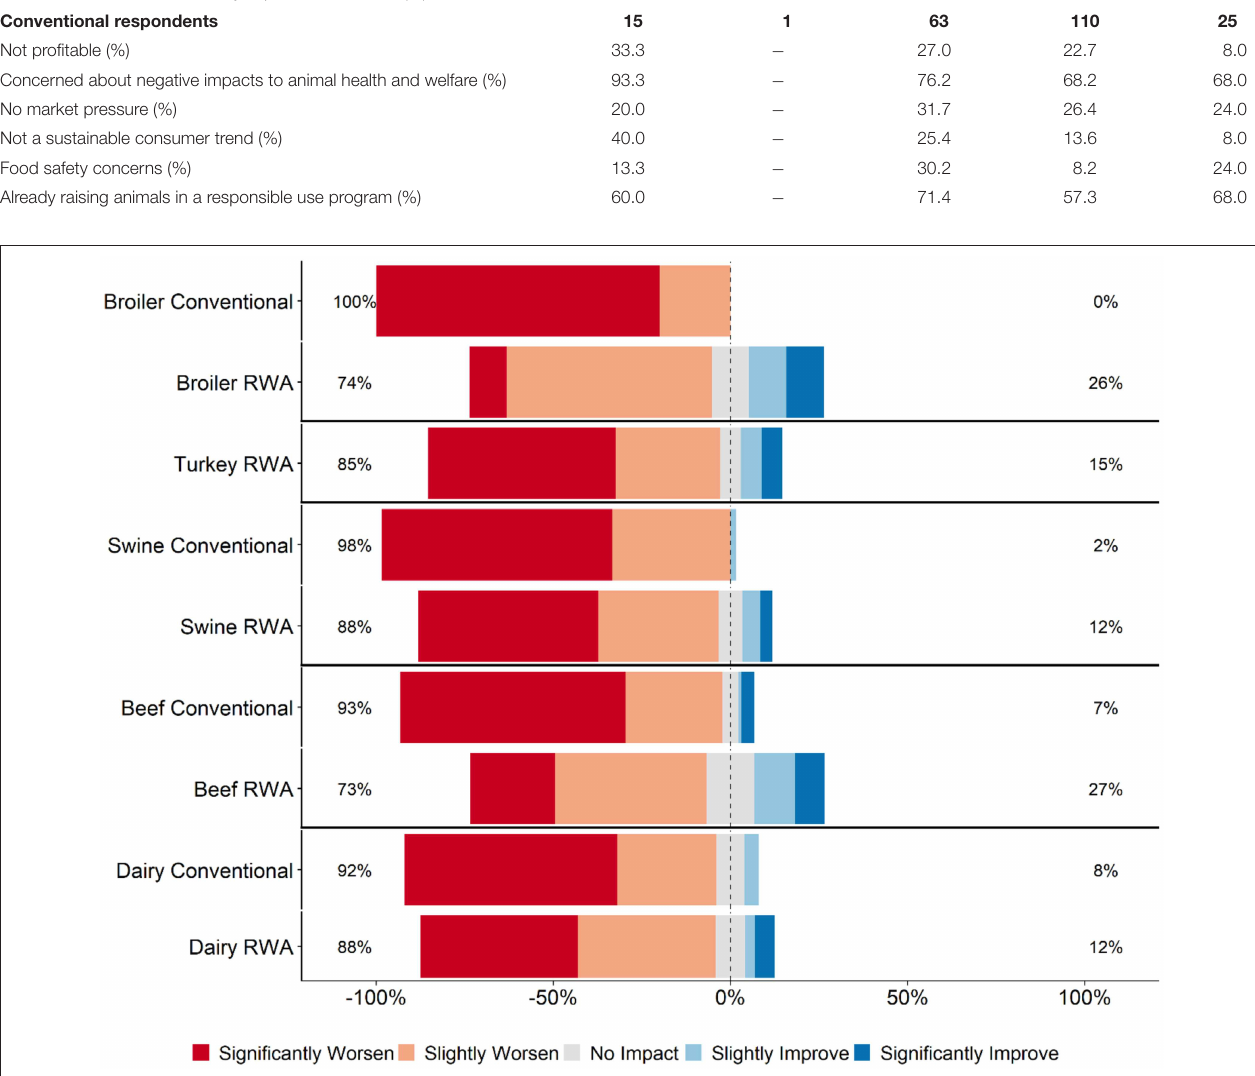
FIGURE 1 | Respondents’ opinion about impact of RWA production on animal health and welfare. Five-item Likert scale reporting respondents’ opinion, stratified by commodity and RWA experience.